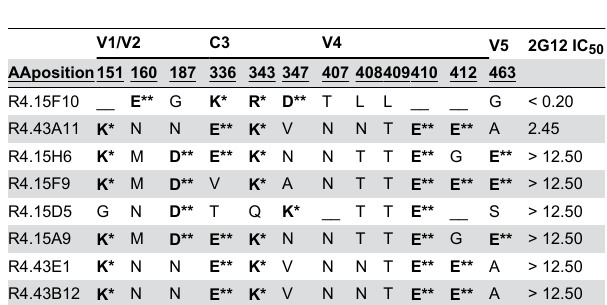
Table 2. Residues in clones from subject ACH18839 with positively charged side chains substituted for residues with neutral, negatively charged chains.